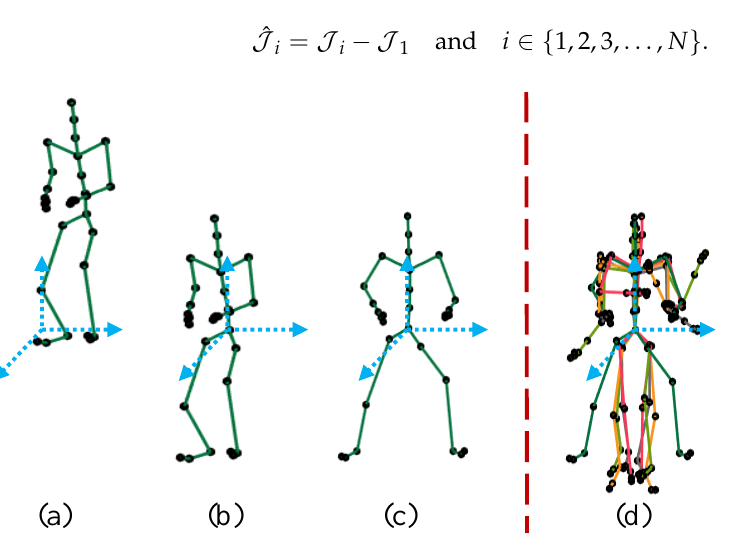
Figure 4. Normalization. ( a ) the original pose; ( b ) the translational normalization; ( c ) orientation normalization; ( d ) multiple normalized